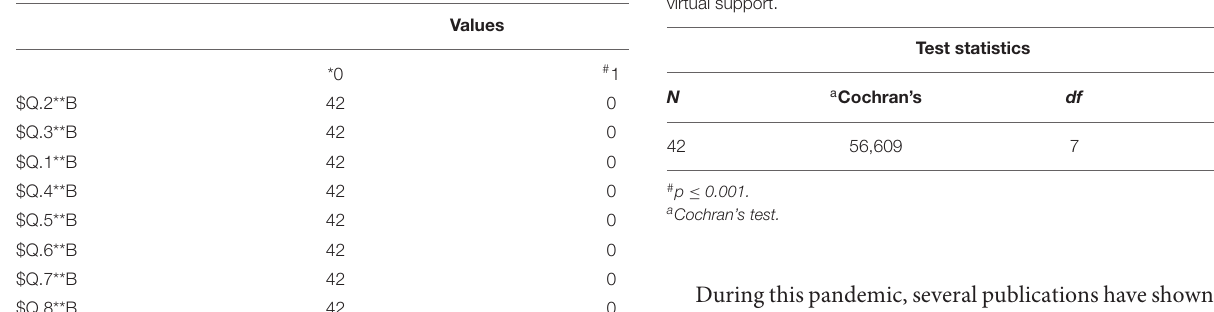
TABLE 1 | Frequencies of caregiver difficulties before the virtual support program.